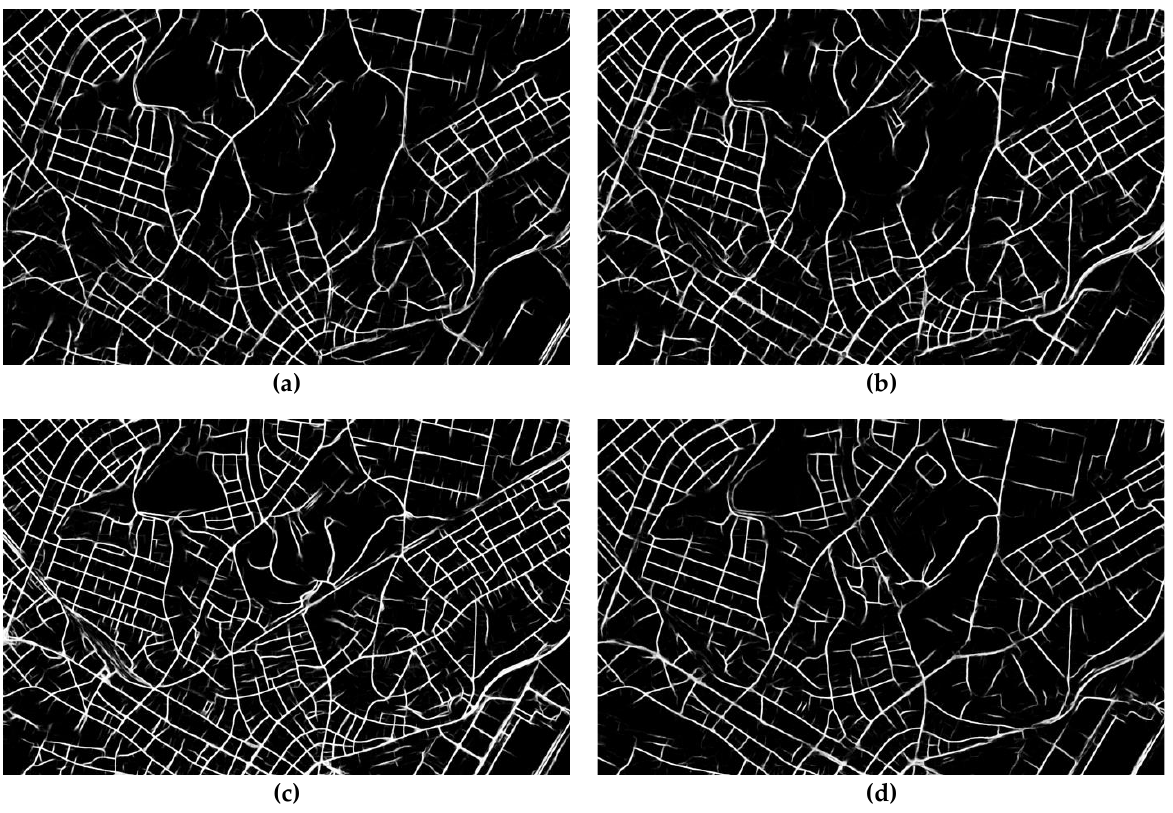
Figure 16. Examples of predicted images produced by road extraction model using (a) old-period aerial photo 1, (b) old-period aerial photo 2, (c) new-period aerial photo and (d) WV-3 image of Hitachinaka area as input.